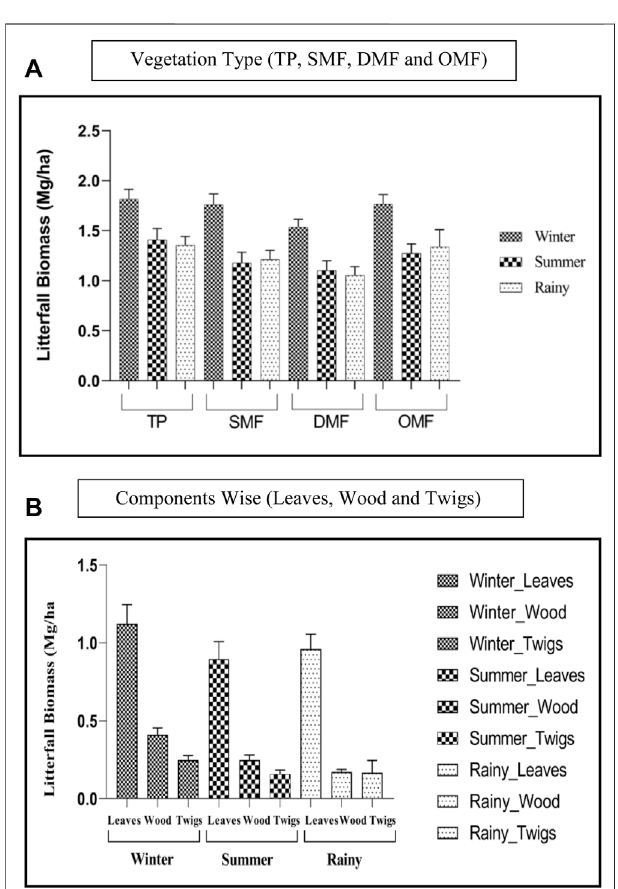
FIGURE 3 | Mean annual seasonal litterfall production in AABR for the period of 2015 – 2019. (A) : vegetation type (TP, SMF, DMF, and OMF). (B) : components wise (leaves, wood, and